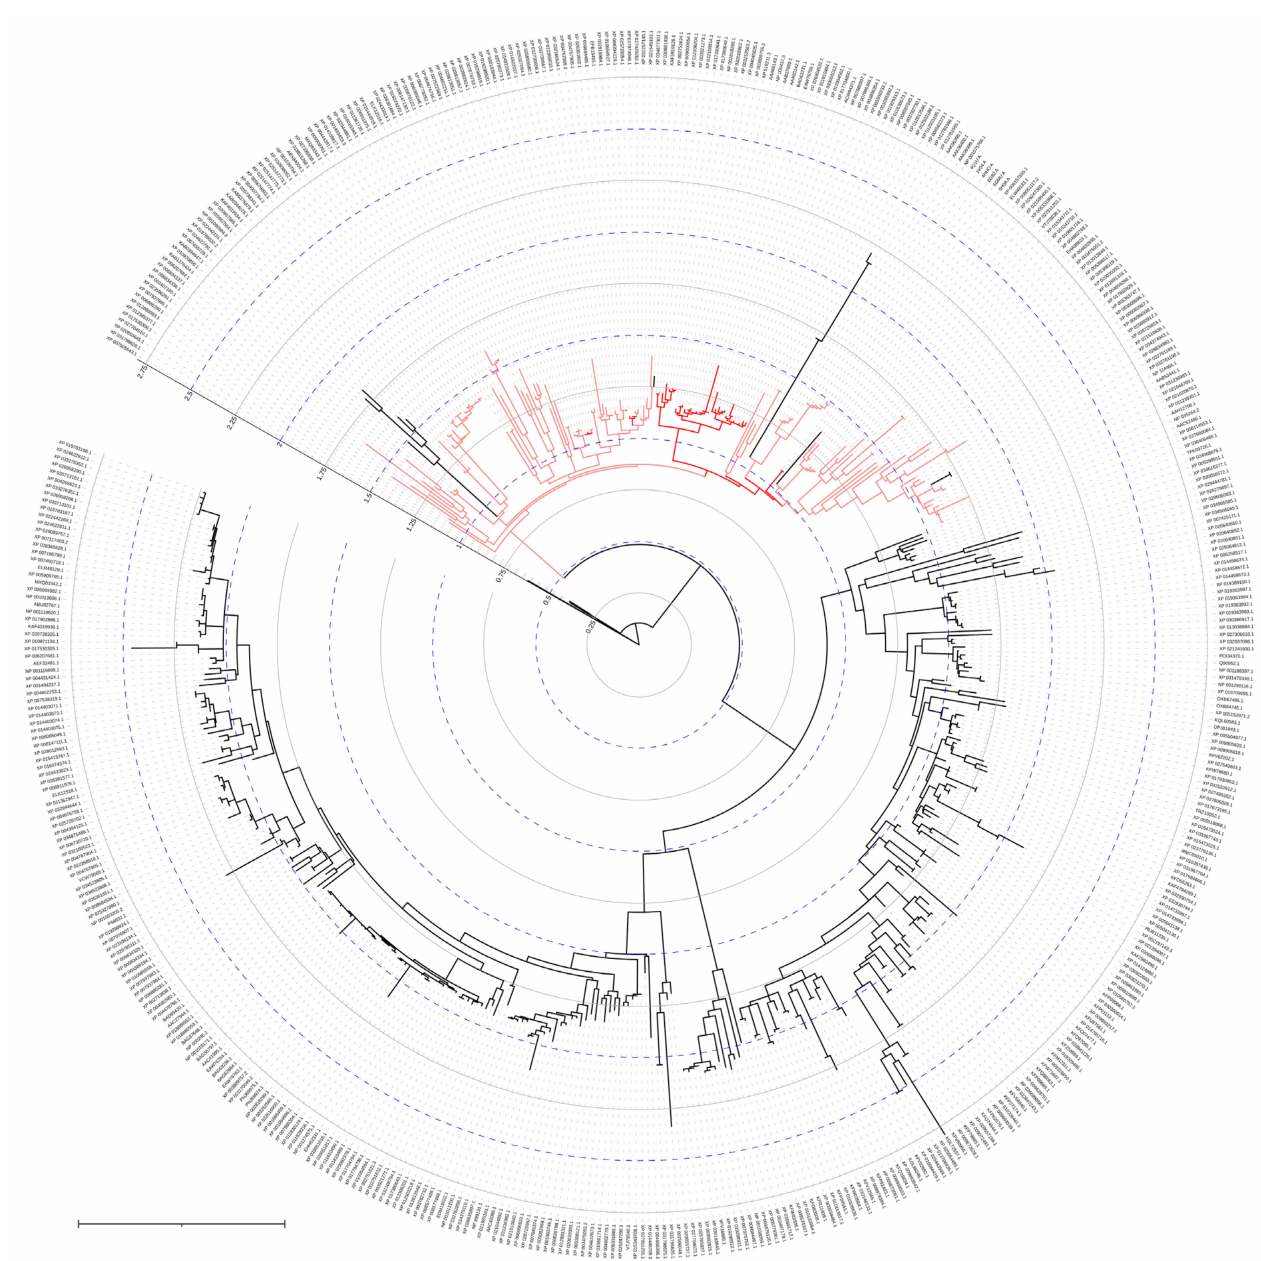
Figure 9. Phylogenetic tree of hPON1 and its homologous enzymes (down to 59% identity). The tree was built as previously with PDB 1V04 as a reference sequence. Enzymes having high (90–100%) and good (80–89%) identity are highlighted with red and pink,